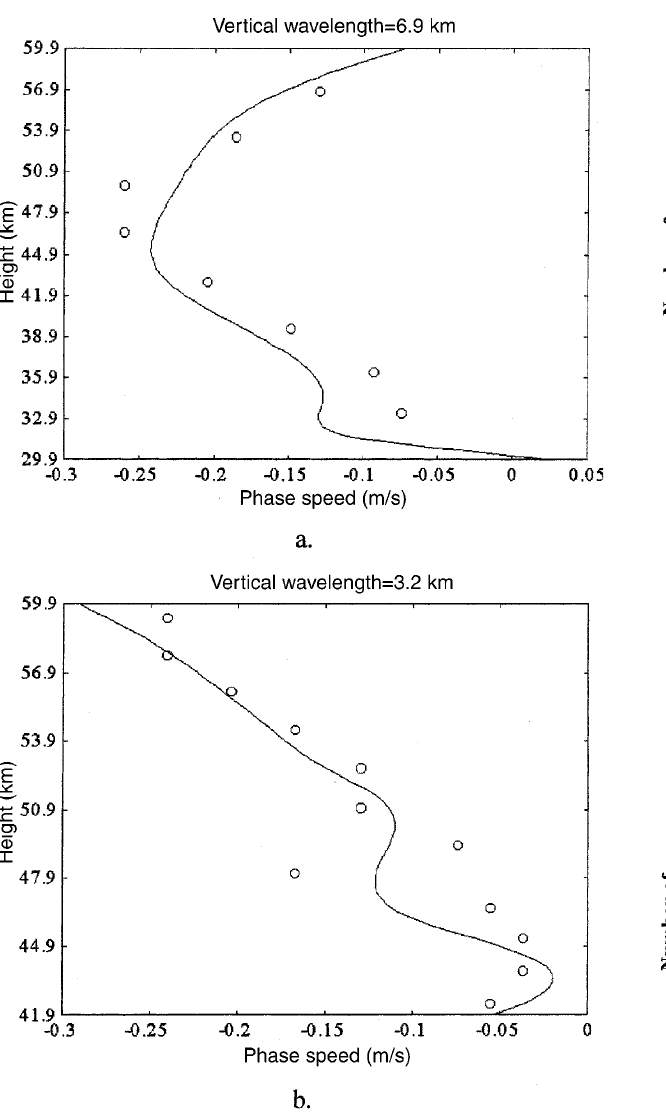
Fig. 8a, b. Phase speed as a function of altitude a for the 6.9-km and b the 3.2-km vertical wavelengths for 30 min average profiles 6 and 9 on June 21. Solid lines and circles represent respectively the phase speed derived from phase sections using the Morlet wavelet and from the maximum and minimum amplitudes of the wavelike structure obtained by the use of the eighth derivative of the Gaussian. This last method takes the vertical wavelength variations into account